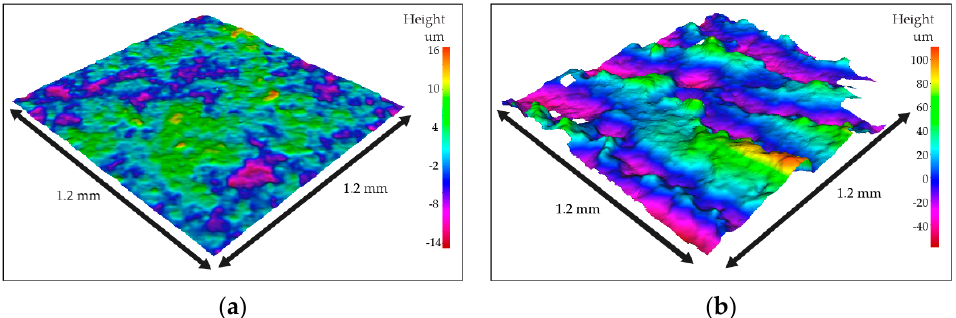
Figure 7. ( a ) A rubber surface scan taken before any testing; ( b ) A rubber surface scan taken after the hardcourt slide testing with noticeable increased roughness through